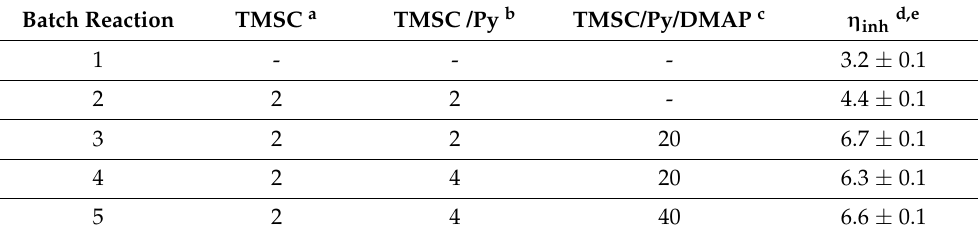
Table 1. Inherent viscosities ( η inh , dL/g) of PPTA as a function of silylating agent, base (Py), and cobase (DMAP). Batch